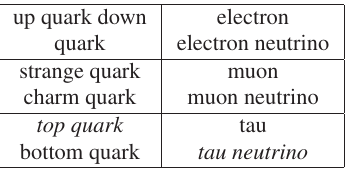
Table 3. Particles of matter, 1989, with hypothesized particles indicated in italic